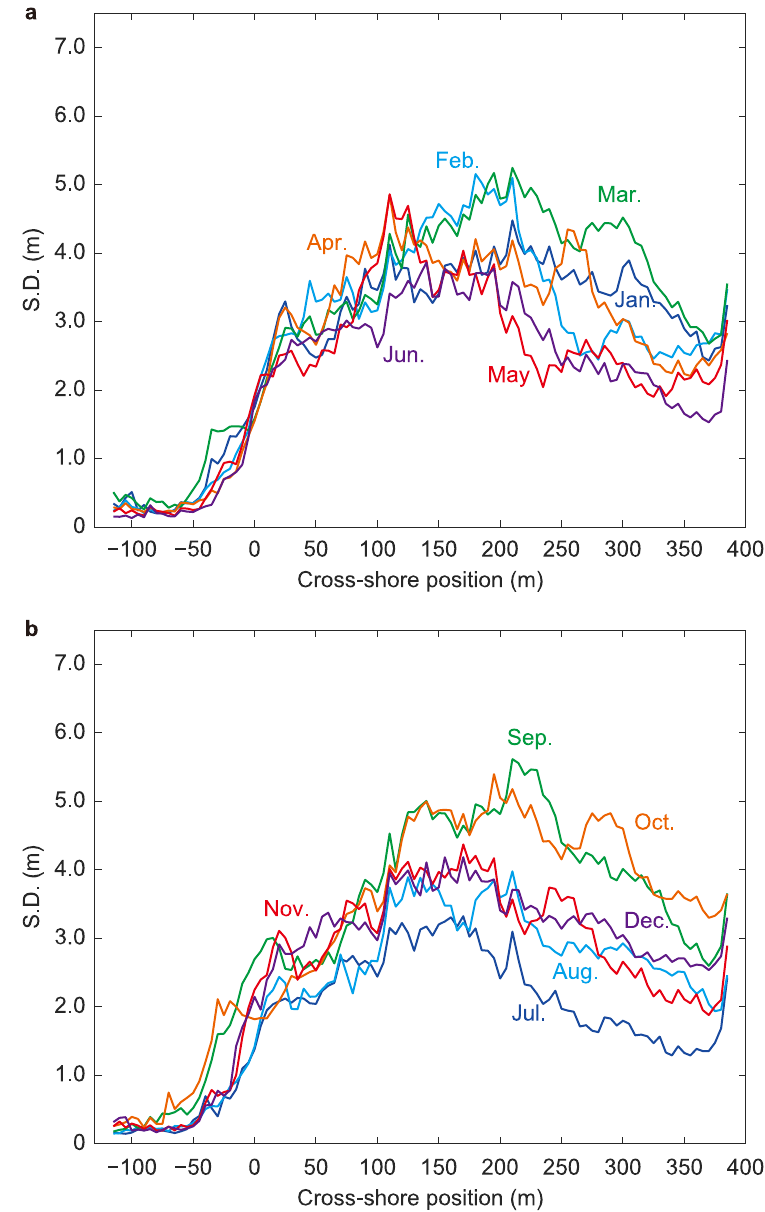
Figure 10. Monthly standard deviation of elevation ( a ) from January to June; ( b ) from July to December.